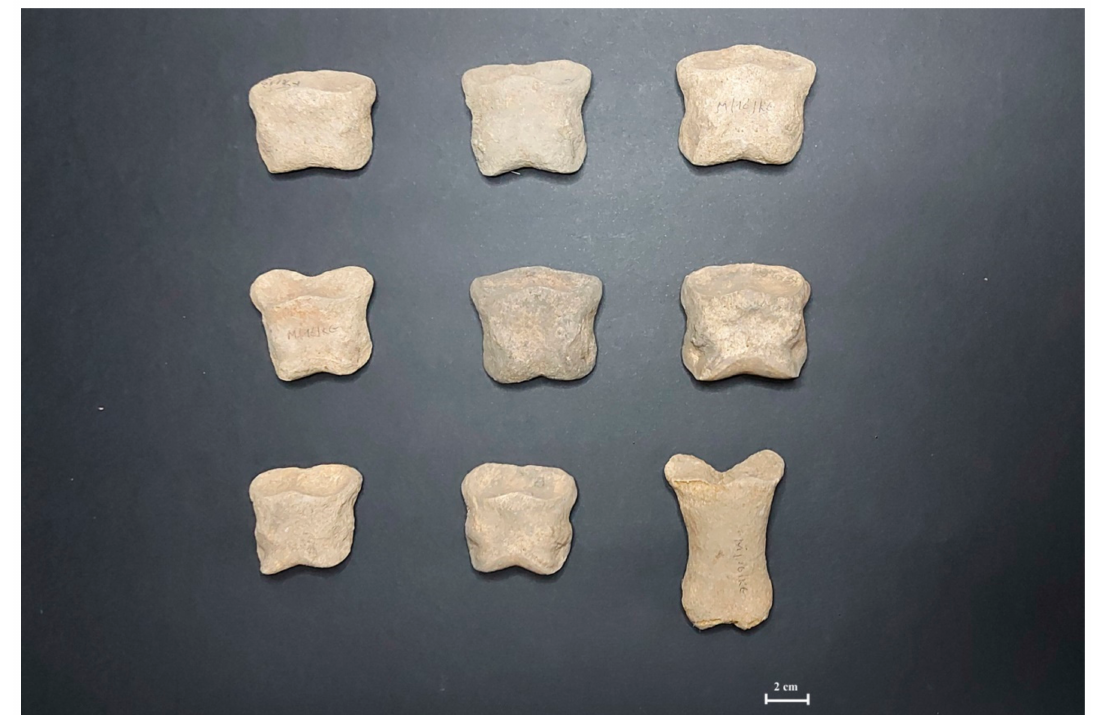
Figure 4. Horse phalanges discovered at Kamienna G ó ra